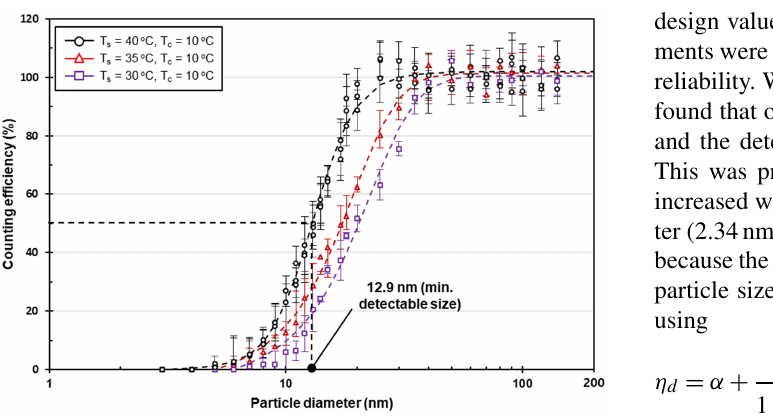
Figure 7. Particle counting efficiency of the MEMS-based CPC as a function of the particle size and saturator temperature. The particle size at which the particle counting efficiency is 50% was 12.9nm ( T S = 40 ◦ C), 17.3 ( T S = 35 ◦ C), and 20.4 ( T S = 30 ◦ C), respec-